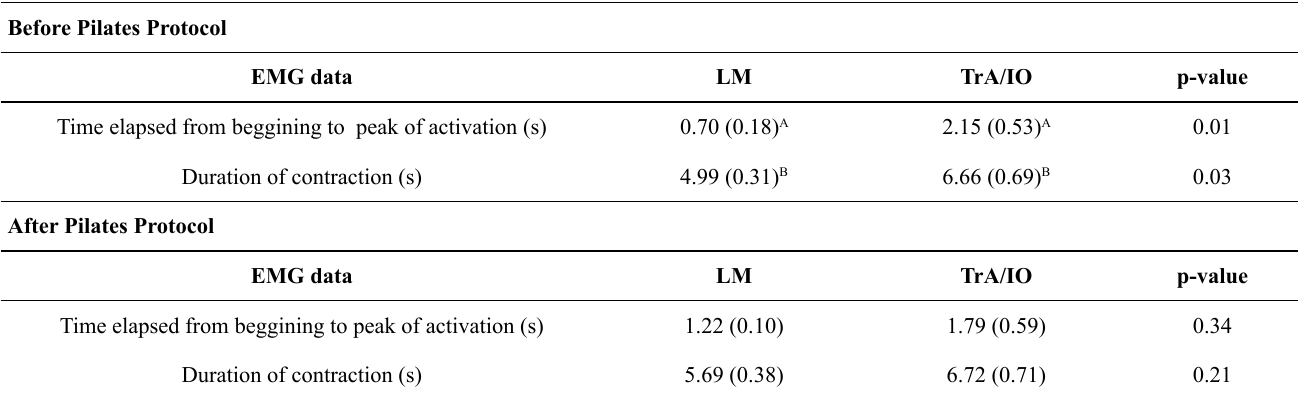
Table 3. Mean (standard error of measurement) of the comparison between temporal parameters of EMG activity of LM and TrA/IO before and after the Pilates protocol.